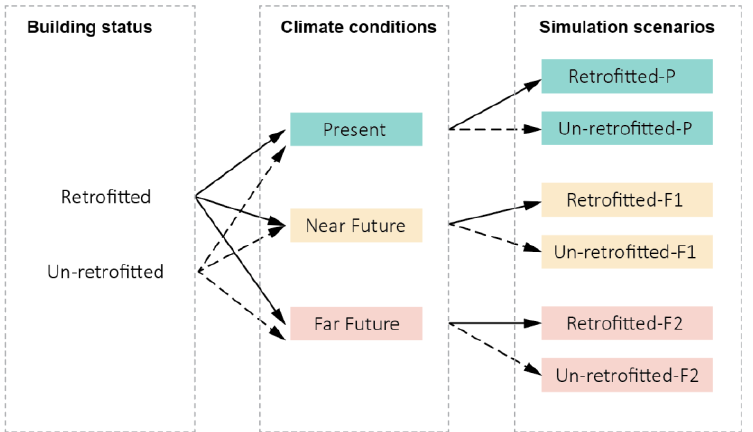
Figure 5. Simulation scenarios defined according to building and climate conditions, P = Present climate condition (2008 – 2011); F1 = Near future climate condition (2041 – 2050); F2 = Far future climate condition (2091 – 2100); Un-retrofitted = historic building in the original state; and Retrofitted = historic building undergone energy retrofit.